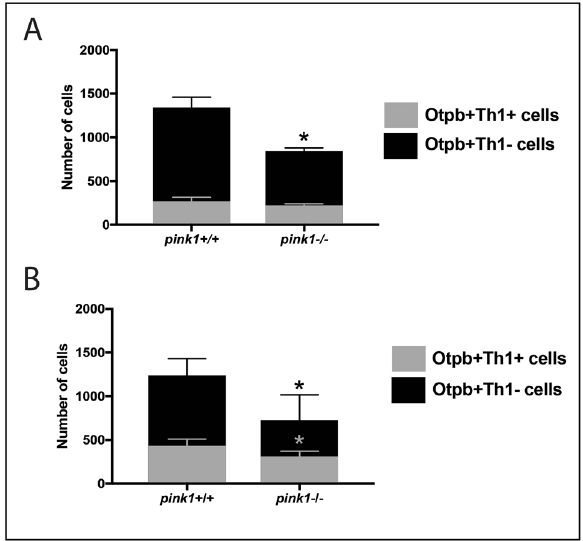
Figure 6. Reduced population of Otp + progenitors in the TPp of pink1 -/- zebrafish at 3 months and 24 months of age. ( A ) Quantification of the number of Otp + Th1 - progenitors and the number of Otp + Th1 + DA neurons zebrafish compared to pink1 +/+ zebrafish ( t -test, p = 0.0292, n = 2 fish for each), but no significant difference in the number of Otp + Th1 + DA neurons . ( B ) Quantification of the number of Otp + Th1 - progenitors and the Otp + Th1 - progenitors in the pink1 -/- zebrafish compared to pink1 +/+ zebrafish ( t- test, p = 0.0259, n = 4 fish